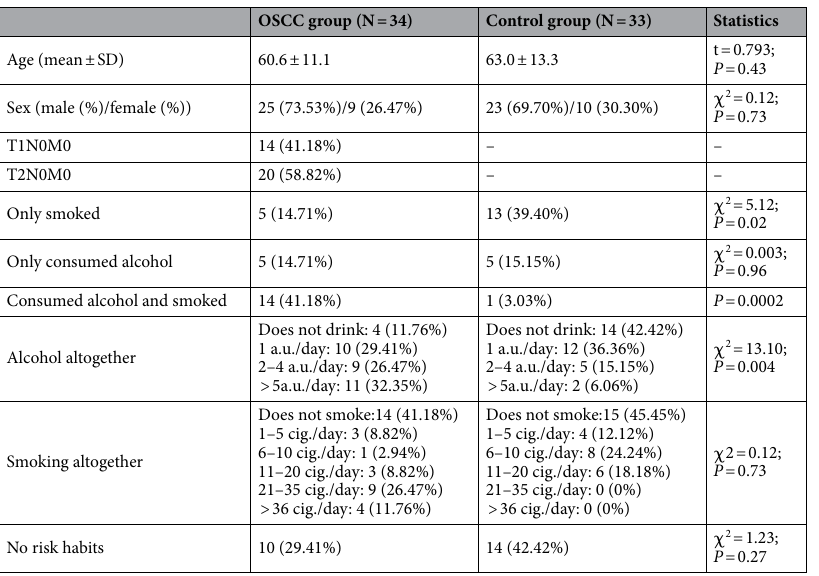
Table 1. Oral squamous cell carcinoma (OSCC) group and control group description. a OSCC oral squamous cell carcinoma, SD standard deviation, a.u . alcohol unit, cig .